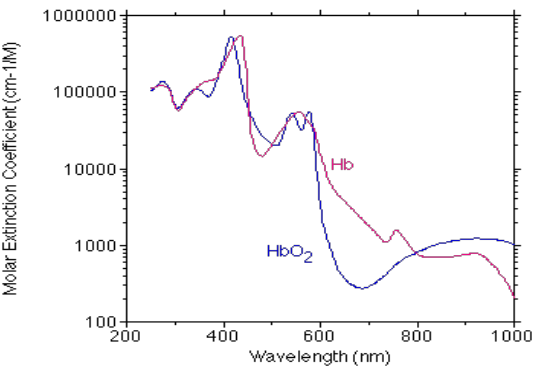
hemoglobin as a function of the wavelength. Prepared by Dr. Scott Prahl from a variety of sources [7]. Used with permission from Dr.